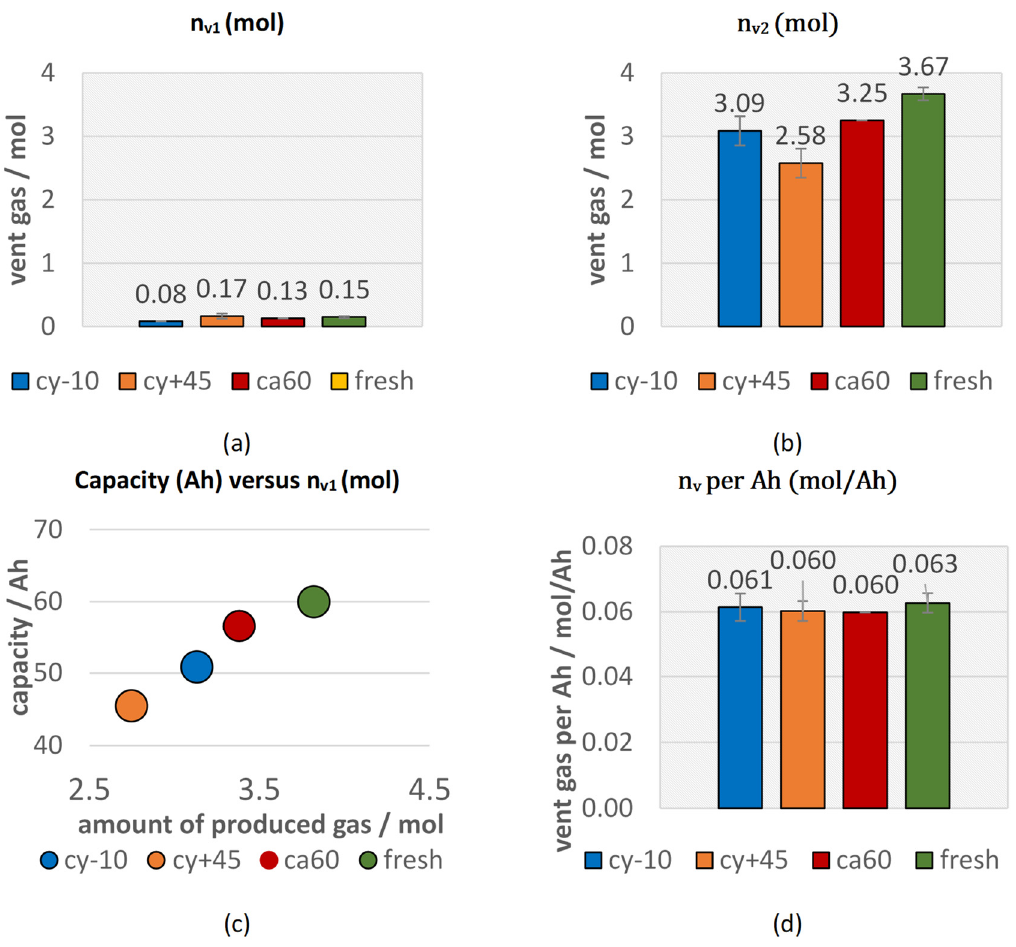
Figure 4. Vent gas emission during overtemperature TR experiments of aged cells (cy − 10: blue, cy+45: orange, ca60: red) compared to fresh cells (green): ( a ) vent gas emission n v1 starting at 𝑻 𝒄𝒆𝒍𝒍𝒗𝟏 and ending at 𝑻 𝒄𝒆𝒍𝒍𝒗𝟐 ( b ) vent gas emission n v2 , ( c ) current capacity of aged and fresh cells versus the total vent gas emission; ( d ) the total vent gas emission per Ah.